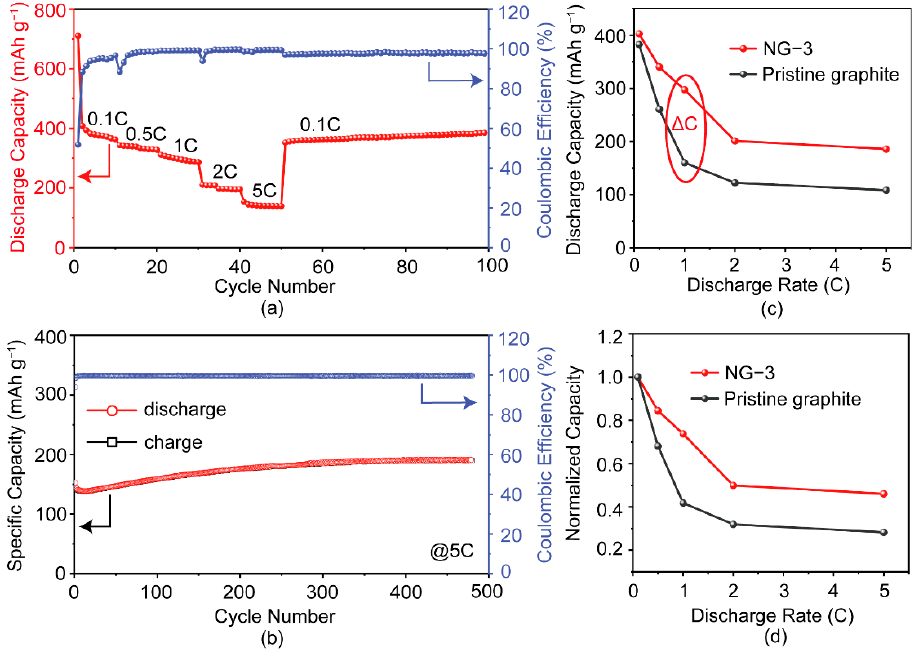
Figure 6. ( a ) Rate capability of discharge capacity and coulombic efficiency for NG-3 at various current rates between 0.01 and 3.0 V vs. Li/Li + . ( b ) The cycle stability of NG-3 at the rate of 5 C. ( c ) The capacity and ( d ) normalized ones at different current rates for pristine graphite and NG-3.